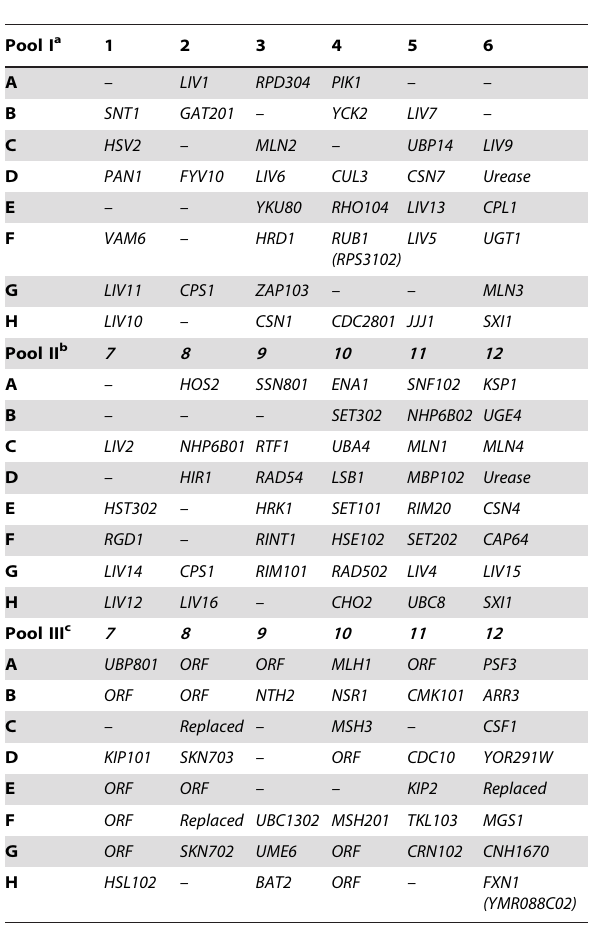
Table 1. Summary of 109 Cryptococcus genes tested in this